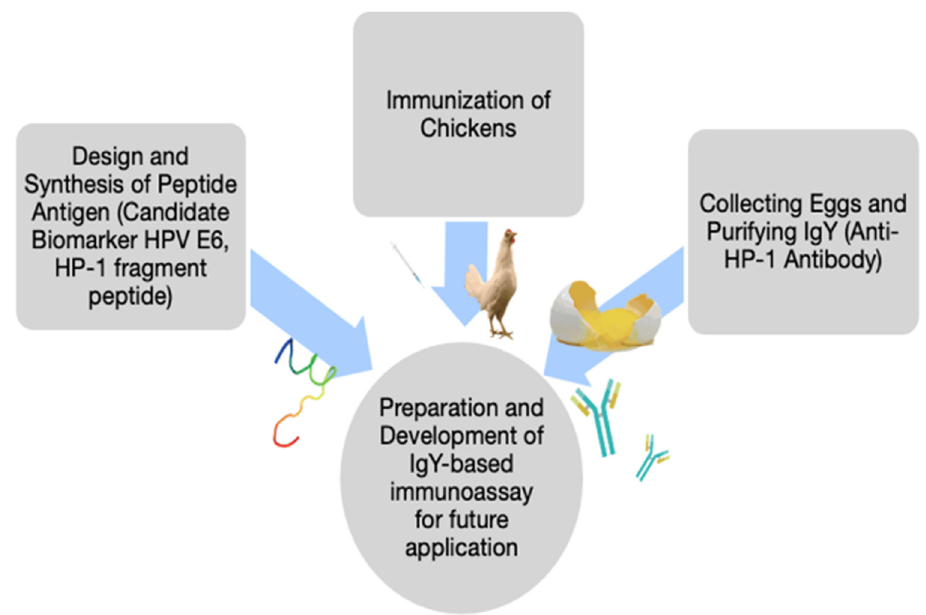
Figure 1. The schematic diagram of synthesis, purification, and analysis of Chicken anti-HP1 IgY.